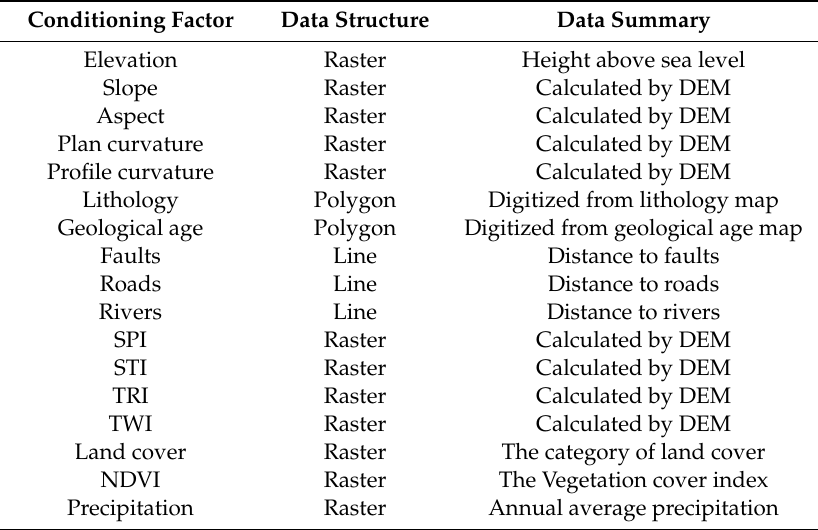
Table 1. Data structures and summaries of landslides conditioning factors.